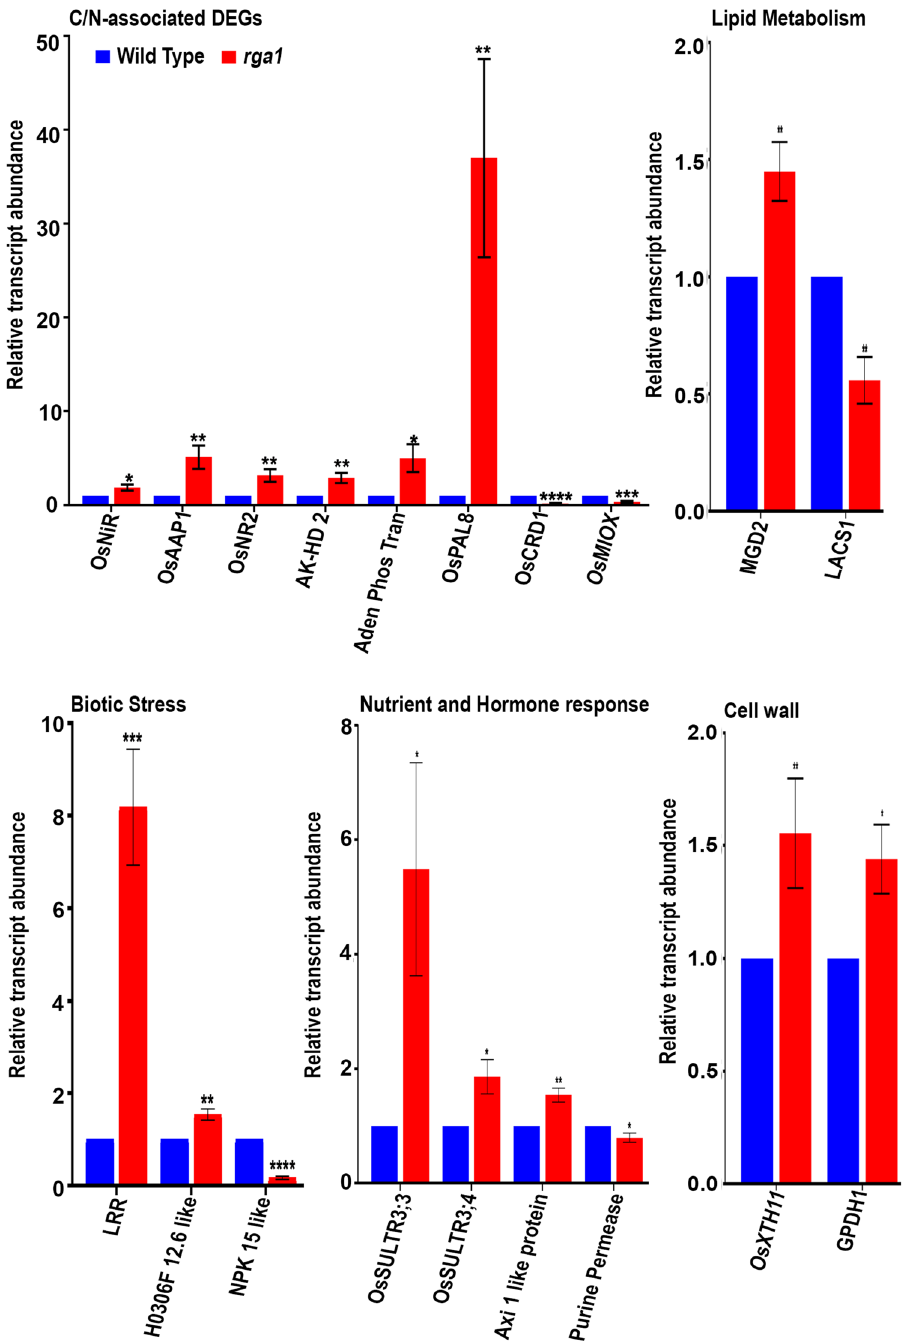
Figure 2. RT-qPCR validation of the regulation of selected DEGs involved in C/N metabolism, lipid metabolism, nutrient and hormone response, biotic stress and cell wall in the rga1 -mutant. RT-qPCR was performed using total RNA isolated from leaves of the wild type and rga1 mutant plants grown under conditions similar to microarray analyses for five DEGs, Aden Phos Tran , OsPAL8, AK-HD 2 , OsXTH11 and OsMIOX , using Actin gene (LOC_Os03g50885) as the internal control. To check the expression of additional DEGs at active tillering stage, leaves from 52 day old plants grown under light intensity of 2800 ± 100 lux were used. Their RNAs were used for RT-qPCR on the genes OsNiR , OsAAP1 , OsNR2 , purine permease, OsCRD1 , GPDH1 , MGD2 , LACS1 , LRR , H0306F 12.6 like , NPK 15 like , OsSULTR3;3 , OsSULTR3;4 and Axi 1 like protein , with actin gene (LOC_Os01g64630) gene as an internal control gene for data normalization. The experiments were performed using two biological and three technical replicates. Relative amounts of transcripts are represented with Mean ± SE. Unpaired t-test analyses was performed using the software GraphPad Prism 6.0 (https ://www. graph pad.com/scien tific -softw are/prism /). * P < 0.05, ** P < 0.01, *** P <